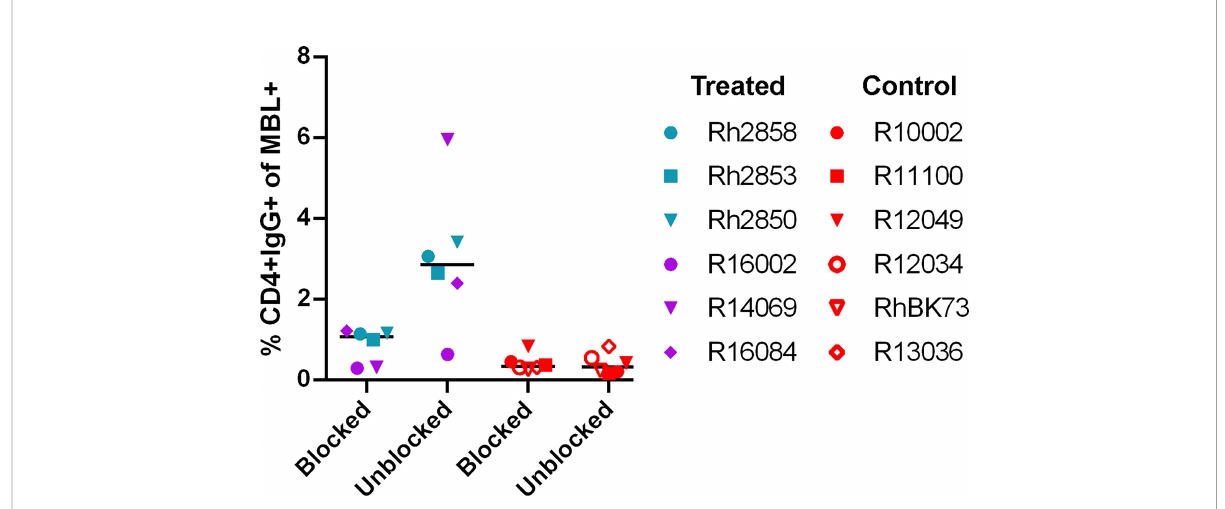
FIGURE 3 Anti-CD4 antibody blocks the majority of binding of anti-CAR antibodies to CAR T cells. The percent of CD4+IgG+ cells in treated animal serum (purple and teal symbols) or control (red symbols). CD4-MBL CAR/CXCR5 target cells were incubated with anti-CD4-BV650 antibody prior to incubation with heat-inactivated serum (blocked) or without prior incubation of anti-CD4-BV650 antibody (unblocked). Bars are drawn at the median. Data is presented for T1 (blue), T2 (teal), T3 (purple) and control (red)